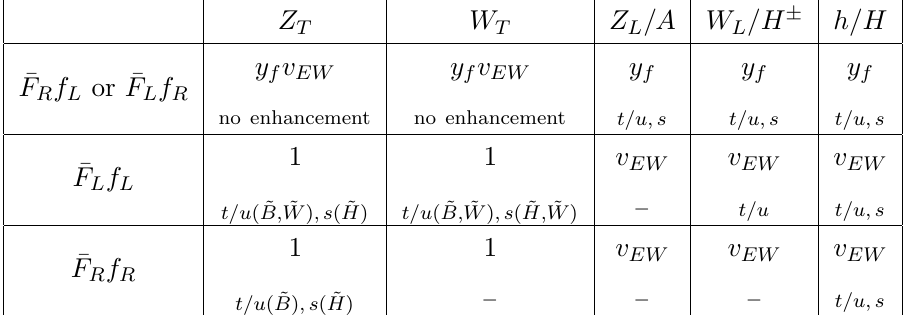
Table 2 . As table 1, but applied to weak gauge and Higgs boson (cid:12)nal states within the MSSM. We also indicated whether the process can be realized with the maximal enhancement allowed by chiral and isospin symmetry in t + u and s -channel annihilation processes, respectively. For the (cid:12)rst two columns we also specify for which neutralino composition ( ~ B = bino-like, ~ W =wino- like, ~ H =Higgsino-like) the maximal enhancement occurs. For the last three columns t + u -channel processes are possible for ~ B - or ~ W -like neutralino as well as mixed ~ H= ~ B or ~ H= ~ W , and s -channel processes are possible for mixed ~ H= ~ B or ~ H= ~ W . Entries with a dash do not contribute to the order we are working in (see appendices A.2 and A.3 for